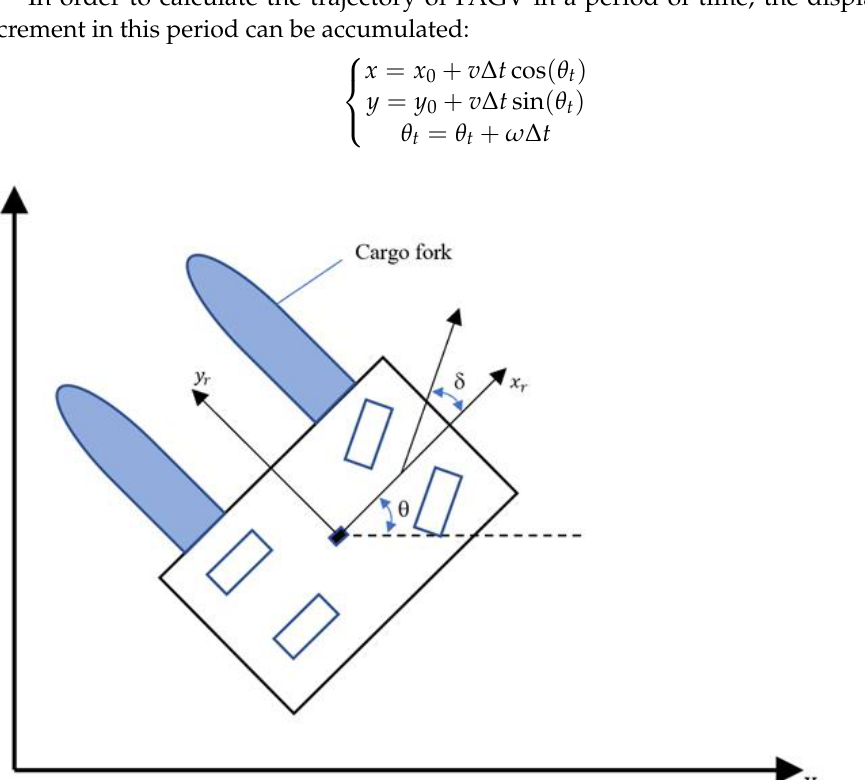
Figure 3. Kinetic model diagram of FAGV.